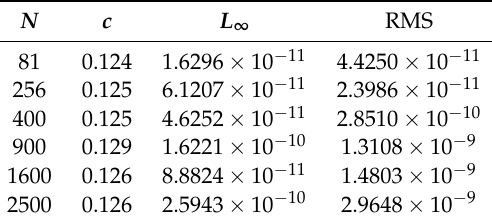
Table 1. Error norms for Problem 1.